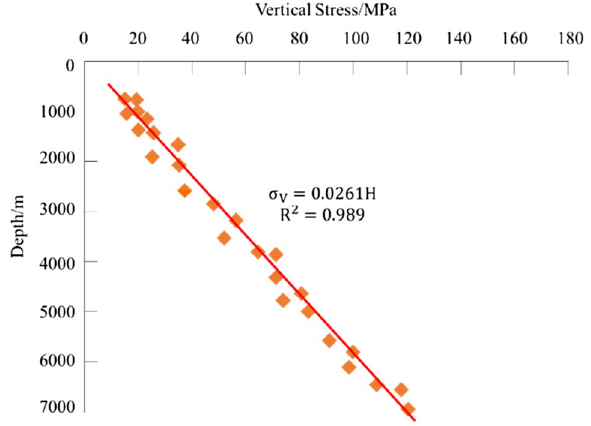
Fig. 8 The variation of vertical in situ stress with buried depth